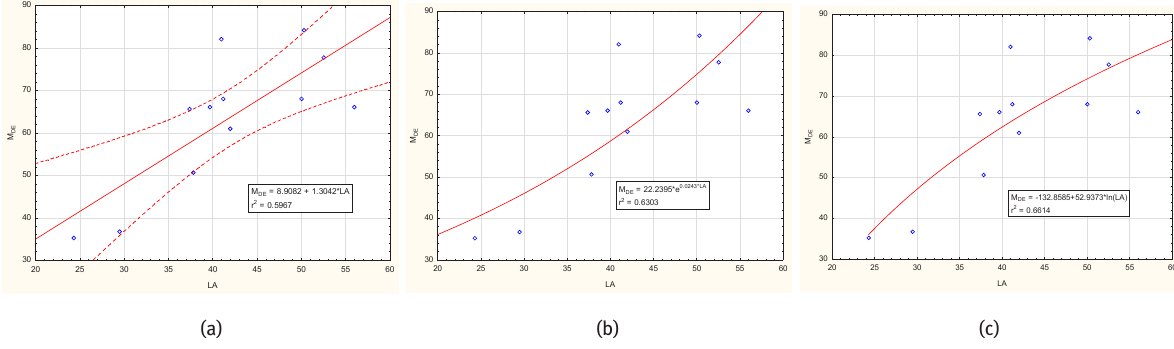
Fig. 9. Function fitting for Krosno sandstone: (a) linear, (b) exponential and (c) logarithmic.